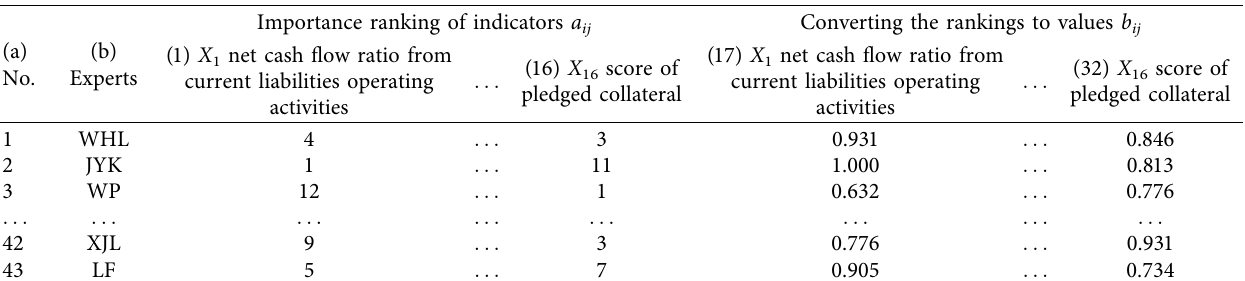
Table 5: The ranking of the experts for 16 indicators and numerical